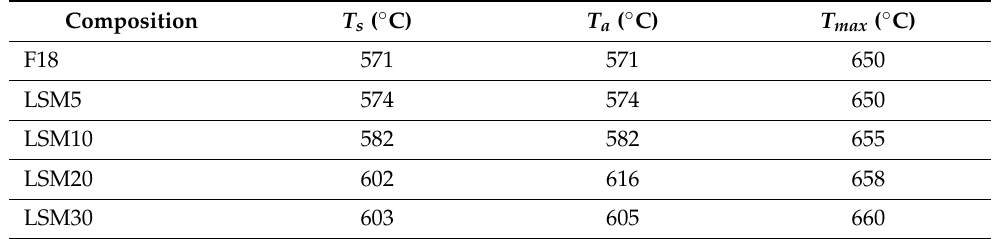
Table 1. Sintering Temperature ( T s ), Softening Temperature ( T a ), Maximum densification temperature ( T max ) in sintering saturation. The typical error in these temperatures is ± 5 ◦